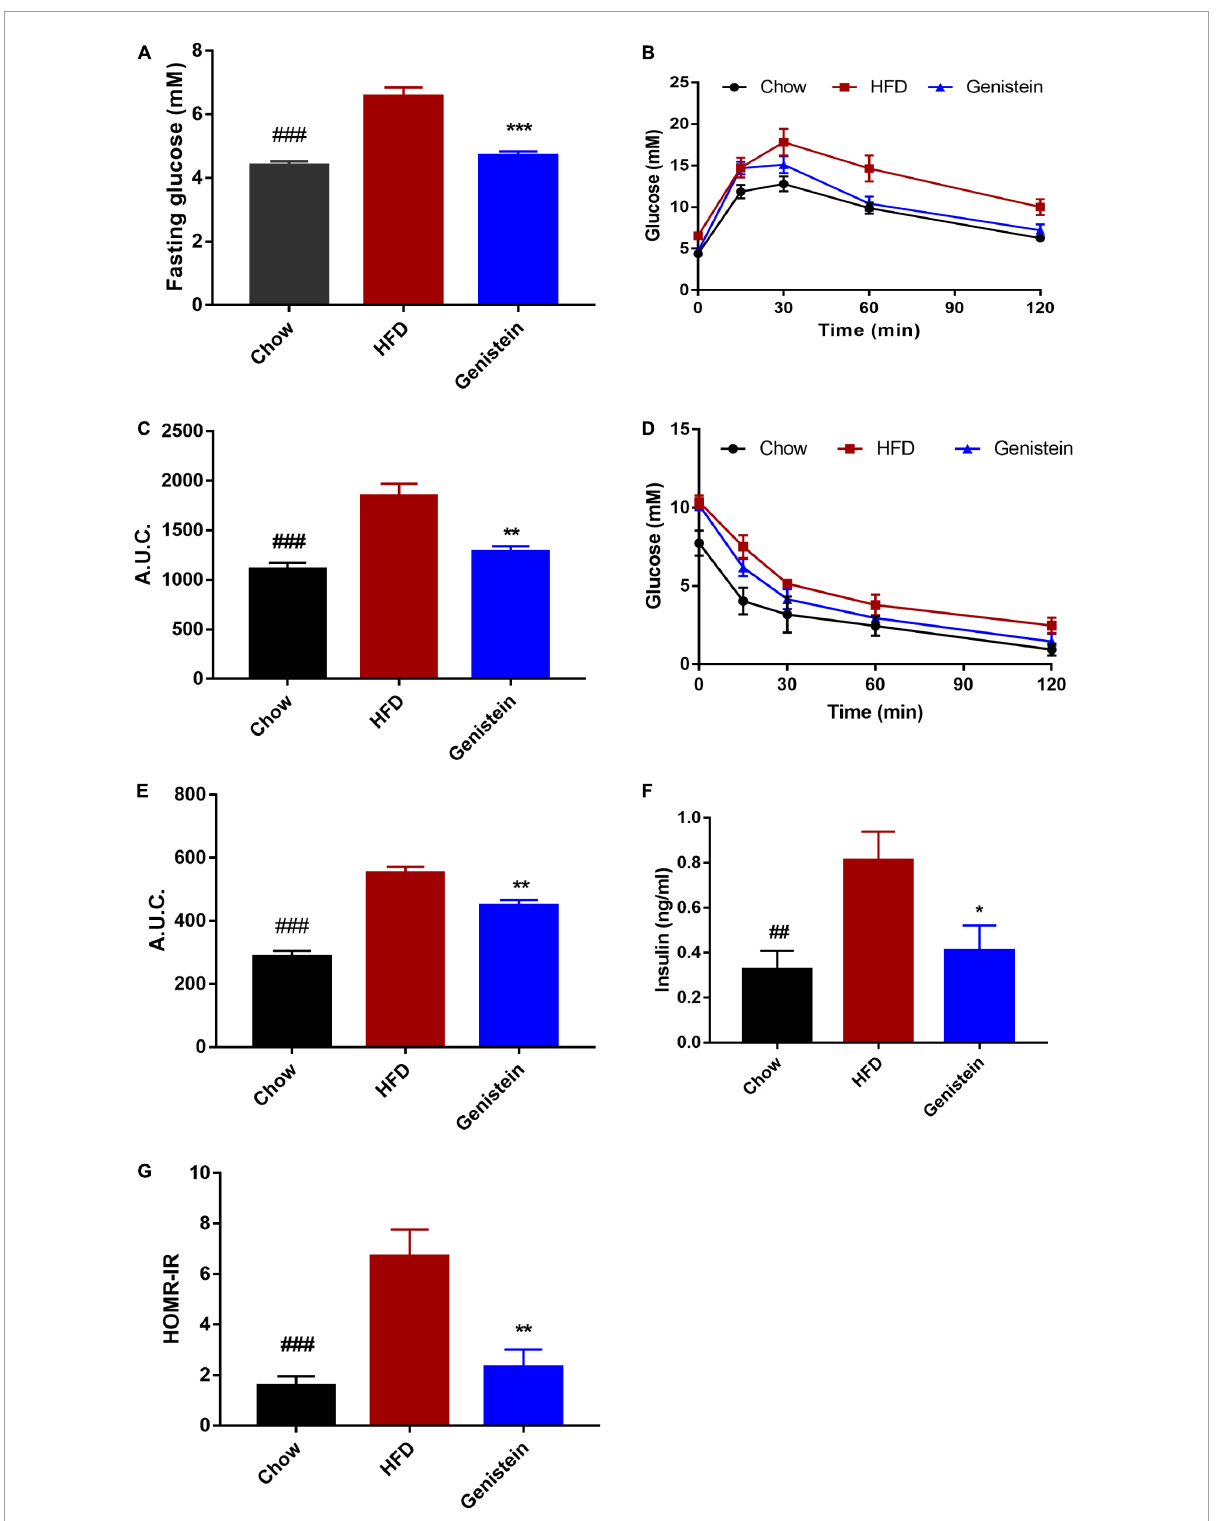
FIGURE1 Genistein treatment prevents hyperglycemia, glucose intolerance, and insulin resistance in diet-induced obese mice. (A) Fasting blood glucose levels. (B) Mice were fasted overnight and subjected to oral glucose tolerance tests (OGTT). (C) Area under the curve in OGTT. (D) Mice were fasted for 4 h and were carried out insulin tolerance tests (ITT). (E) Area under the curve in ITT. (F) Fasting insulin levels. (G) The homeostatic model assessment of insulin resistance (HOMA–IR) index. Data are presented as means ± SEM; n = 6 mice/group. ## p < 0.01 and ### p < 0.001 for Chow vs. HFD. * p < 0.05, ** p < 0.01 and *** p < 0.001 for Genistein vs.